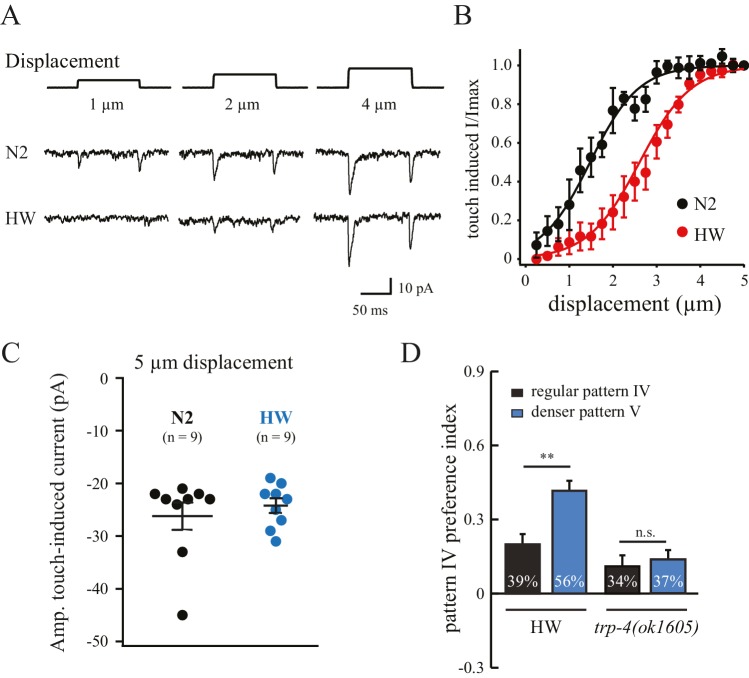
Polymorphisms in TRP-4 alter mechanosensitivity of dopaminergic neurons.(A) Representative traces of mechanoreceptor currents in wild type N2 and HW dopaminergic CEP neurons in response to small mechanical displacements (1 μm, 2 μm and 4 μm). Whole-cell patch clamp recordings (holding potential at −75 mV) were carried out at 20°C. (B) Stimulus-current curves of TRP-4 mechanogated on-currents in response to mechanical displacement. Data were fitted with a Boltzmann function. For N2 worms, the half-maximal displacement is 1.48 ± 0.04 µm and the slope factor is 0.56 ± 0.04 µm. For HW worms, the half-maximal displacement is 2.71 ± 0.03 µm, the slope factor is 0.58 ± 0.03 µm. n = 8 for N2 and n = 6 for HW; **p<0.01 and *p<0.05 when compared with HW worms. (C) A comparison of absolute current amplitudes in N2 and HW worms (at 5 µm displacements, n = 9 for N2 and n = 9 for HW). (D) Increases in pillar density in pattern IV enhanced HW aggregation but had little impact on trp-4(ok1605) mutant worms. Denser pattern V consisted of a pillar layout of 194 µm (pillar diameter) x 95 µm (distance between pillars). **p<0.01. Error bars denote s.e.m.